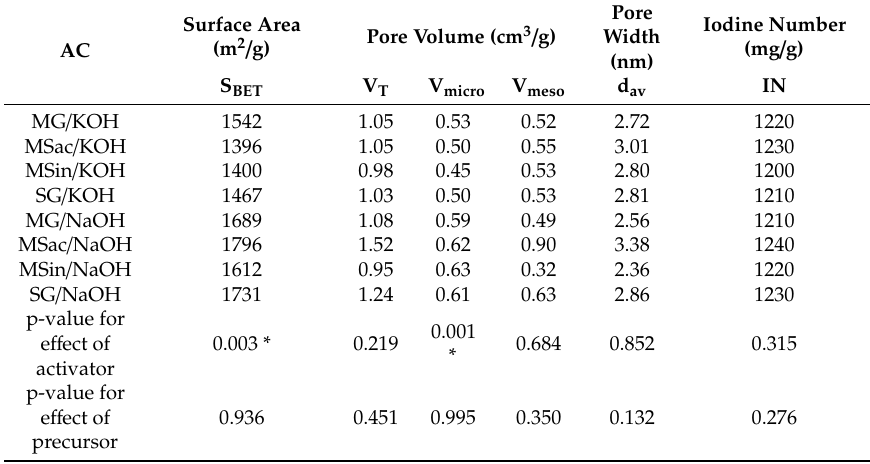
Table 5. Parameters of the porous structure in activated carbons derived from miscanthus and switchgrass lignocellulosic